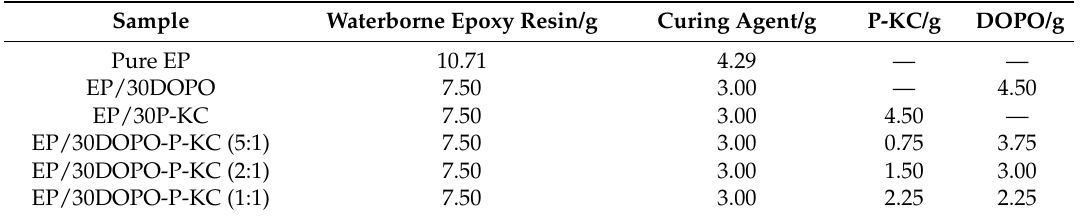
Table 1. Formulations of coatings.